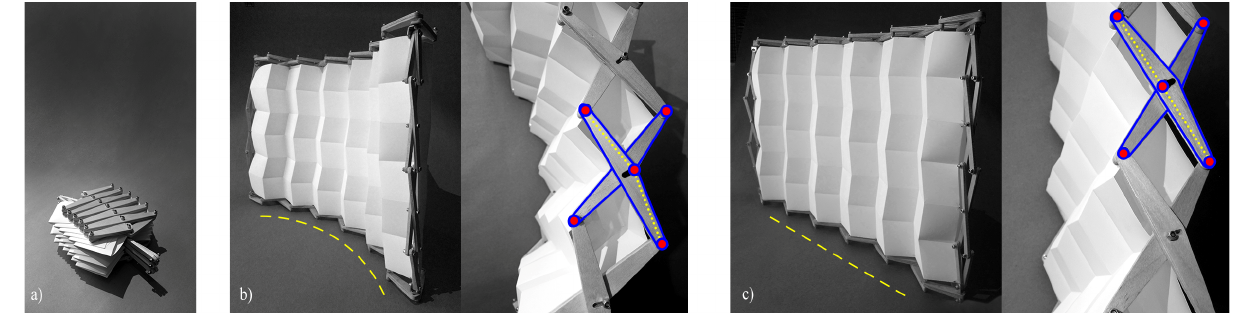
Figure 8: Physical model of a biaxial transformation structure consisting of a non-rigid arc-miura CP: a) retracted, b) expanded along arc and modified scissor detail, c) expanded linear and modified scissor detail